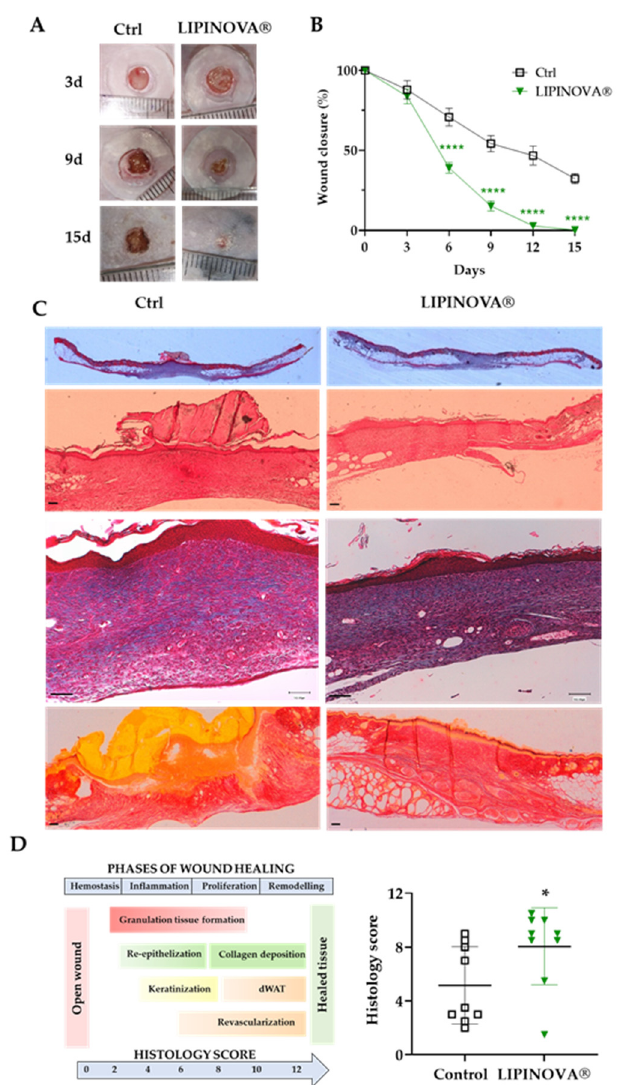
Figure 4. The effect of topical LIPINOVA ® on cutaneous wounds in db/db mice. ( A ) Representative images showing wounds of mice treated with saline (Ctrl) or with 50 ng LIPINOVA ® at different time points (day 3, 9, and 15). ( B ) Kinetics of wound closure assessed at different time points as a percentage of the initial area in saline- and LIPINOVA ® -treated animals ( n = 9 animals per group, 2 wounds per animal). Data are represented as mean ± SEM. Two-way ANOVA was used for statistical analysis. ( C ) Representative images of wound sections stained with H&E, Masson’s trichrome, and Picrosirius red at day 15. Images were acquired at different magnifications; scale bar = 100 µ m. ( D ) Histology score represented as mean ± SD of mice treated with 50 ng LIPINOVA ® or saline obtained from H&E- and Masson’s trichrome-stained skin sections 15 days post-wounding. Dermal white adipose tissue (dWAT). The Mann–Whitney U test was used for statistical analysis; * p < 0.05, **** p < 0.0001.